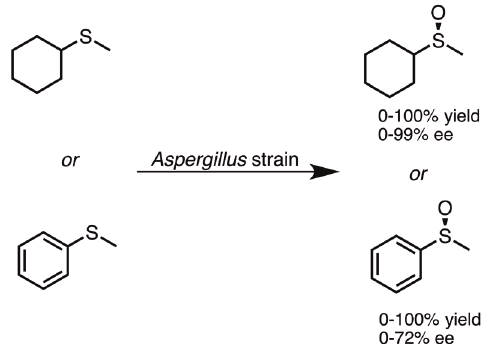
Figure 13 - Use of several Aspergillus strains as biocatalysts for the oxidation of cyclohexyl(methyl)sulfide and alkyl aryl